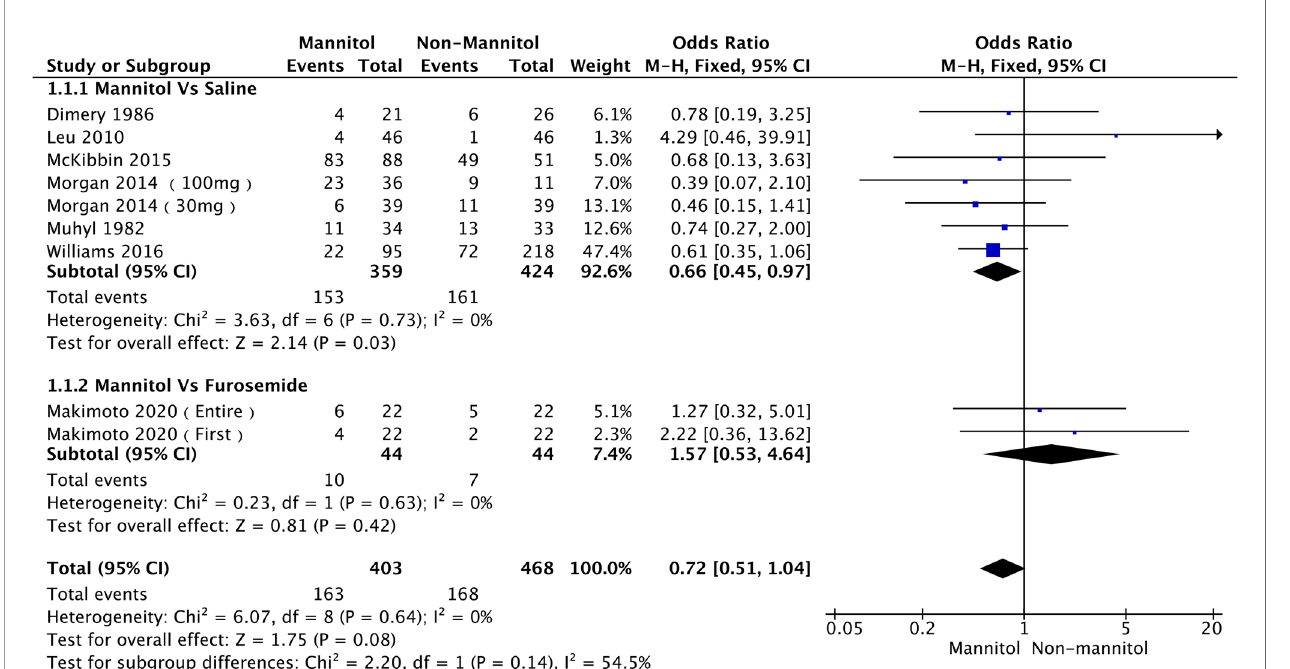
FIGURE 4 | Forest plot of odds ratios (OR) for incidence of cisplatin-induced nephrotoxicity (ICN).